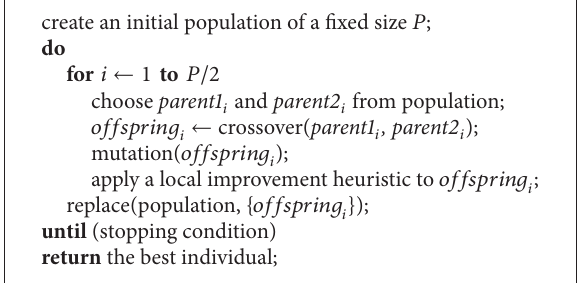
Figure 2: Relationship between distances on solution space and those on Lagrangian space (among locally optimal Lagrangian vectors). ∗ 𝑥 -axis: distance between Lagrangian vectors, 𝑦 -axis: distance between binary solution vectors, and 𝜌 : Pearson correlation coefficient.